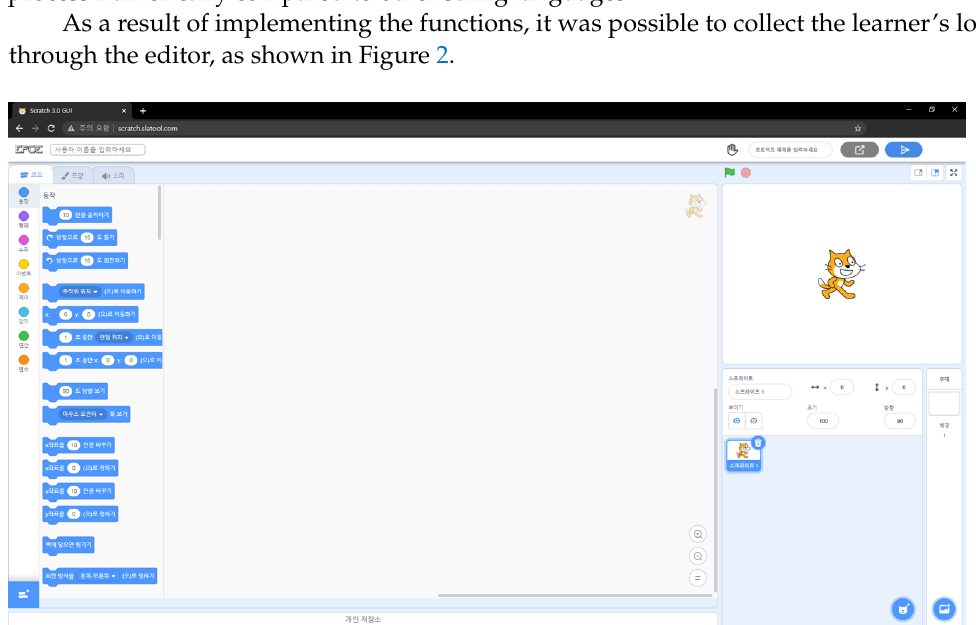
Figure 2. A view of the programming log crawler used in the